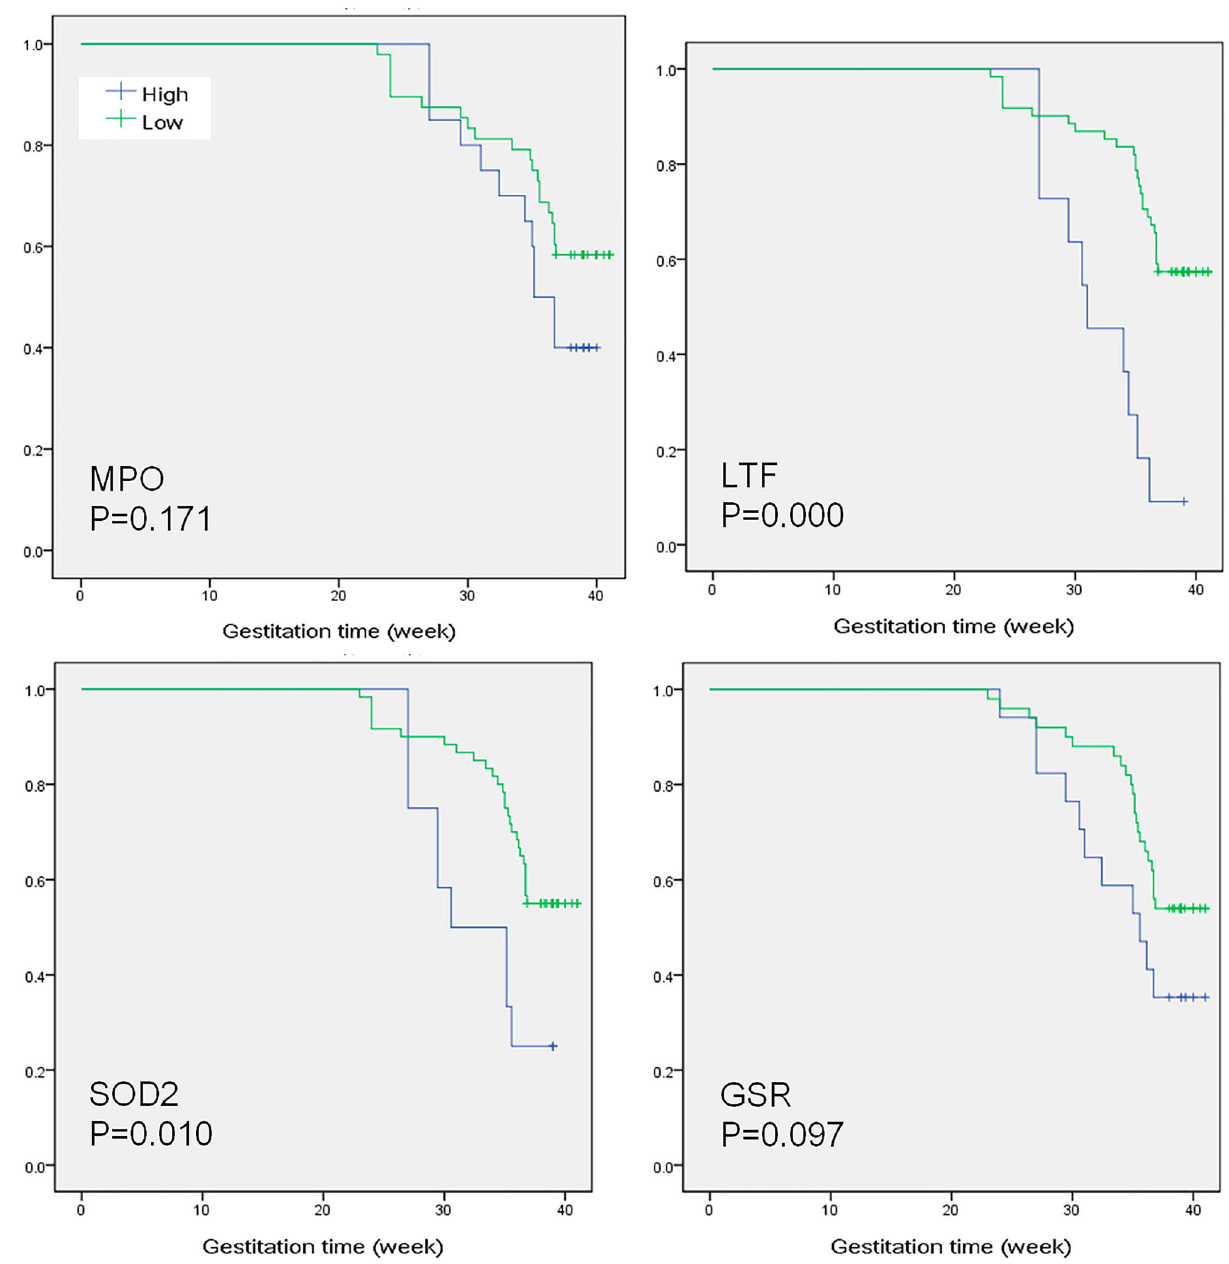
Figure 5. Survival rate analysis. For each participant, we inputted only the protein biomarker concentration and gestational age without providing FT or PT information. Then, we conducted survival rate analysis by mimicking the assays used in tumor biology. This analysis was performed with SPSS. The p values were calculated with the log-rank